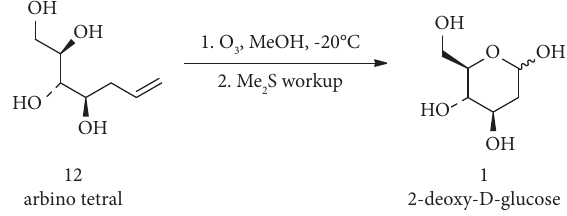
Figure 6: Synthesis of 2-deoxy-D-glucose (1).